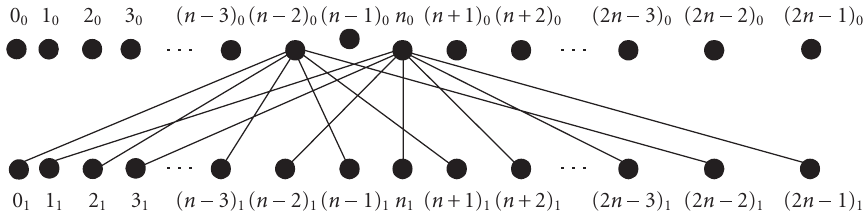
Figure 5.2. Symmetric starter of an ODC of K 2 n ,2 n by G = 2 S n ∪ E 2 n − 2 with respect to Z 2 n , n is